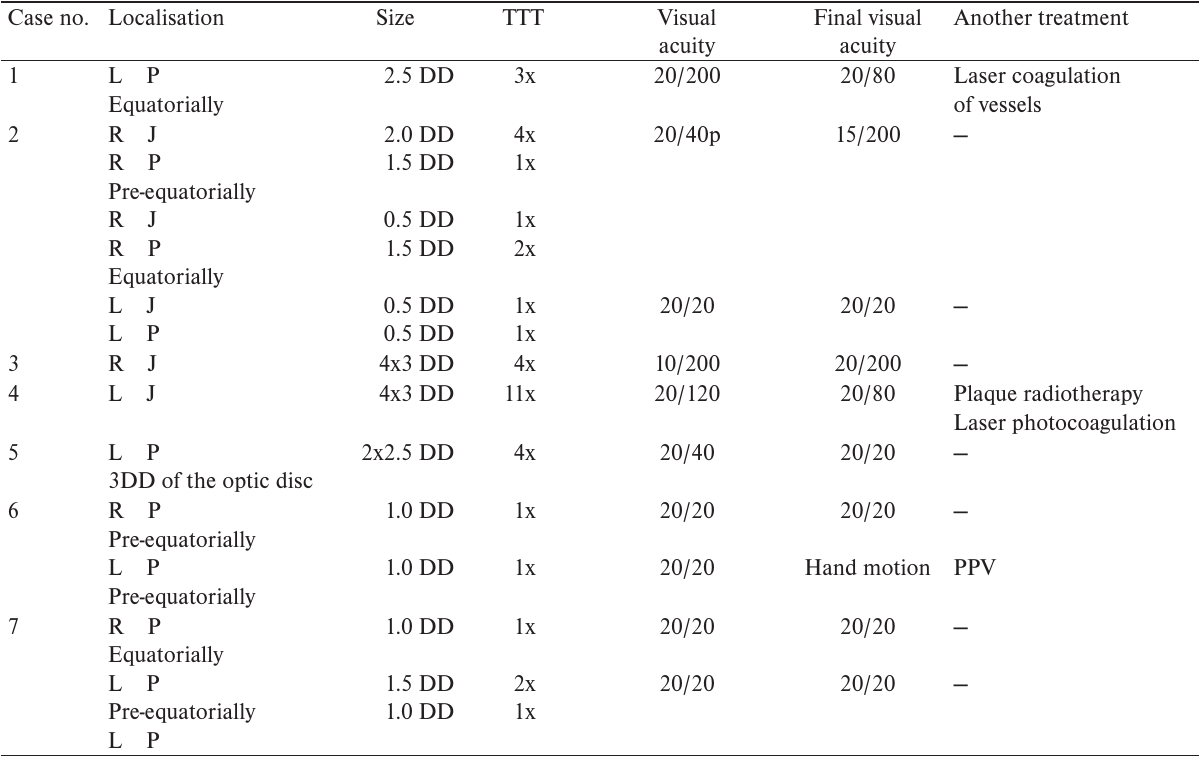
Table 2. Results of